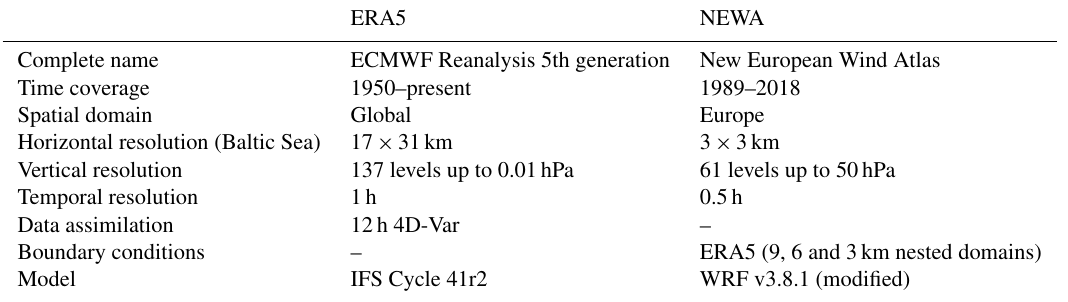
Table 1. Mean characteristics of used numerical